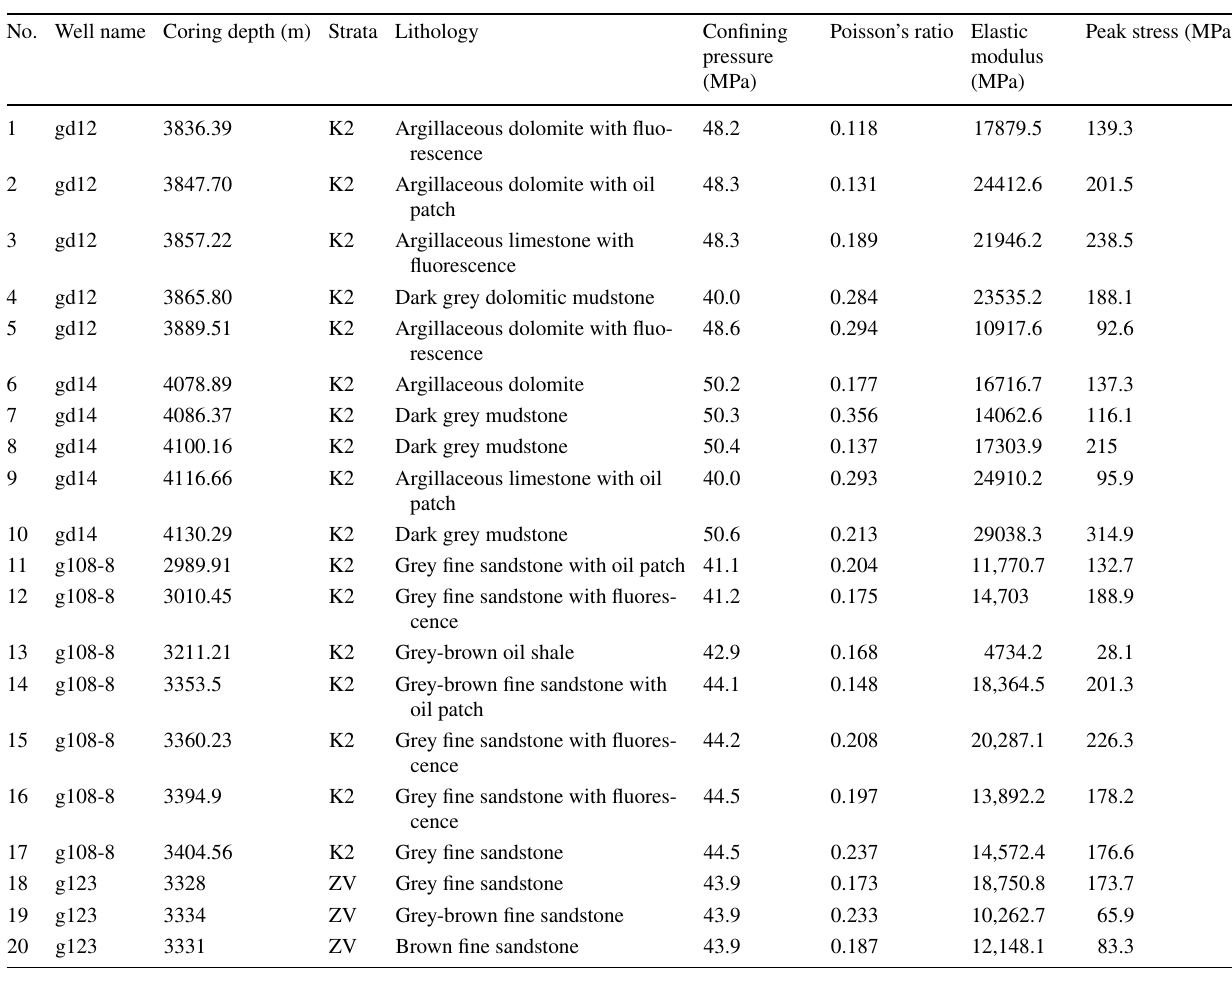
Table 1 Results of triaxial rock mechanics tests No. Well name Coring depth (m) Strata Lithology